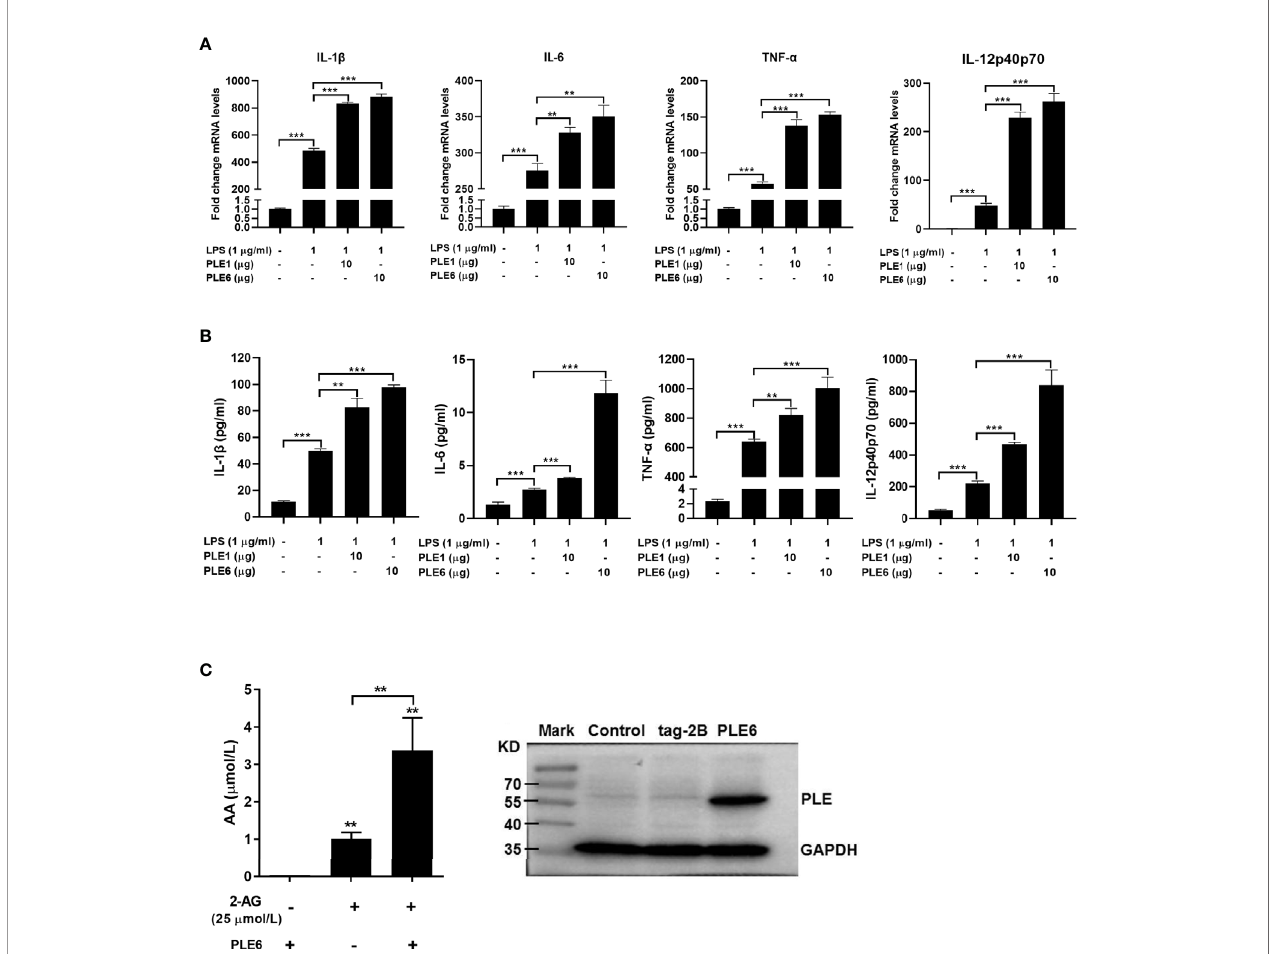
FIGURE 3 | Enhanced LPS-stimulation on the expression of proin fl ammatory cytokines in PAMs by addition of PLE1/6 or increased AA secretion in transfected PLE6. (A) Enhanced LPS-stimulation on the mRNA expression of proin fl ammatory cytokines in PAMs by addition of puri fi ed PLE1 or PLE6. PAMs were cultured for 24 h, and then treated with LPS (1 µg/ml) and PLE1 or PLE6 (10 µg). After incubation for additional 6 h, total RNA was isolated and analyzed for the mRNA level of proin fl ammatory cytokines by RT-qPCR. (B) Enhanced LPS-stimulation on the protein expression of proin fl ammatory cytokines in PAMs. Cells were treated as Experiment A (above). However, culture supernatant was collected and analyzed by protein chip. (C) Increased AA secretion by PLE6 transfected cells. 293T cells were transfected with pCMV-tag-2B-PLE6 or the corresponding vector. The transfected cells were treated with 2-AG (25 µM). After treatment for 1 h, the supernatant was extracted and analyzed for the level of AA by LC-MS/MS (Left). The expression of transfected PLE6 was con fi rmed by Western blotting (Right). Data are presented as the mean ± SEM of 3 independent experiments. Statistical signi fi cance was indicated by asterisks (** P < 0.01; *** P <